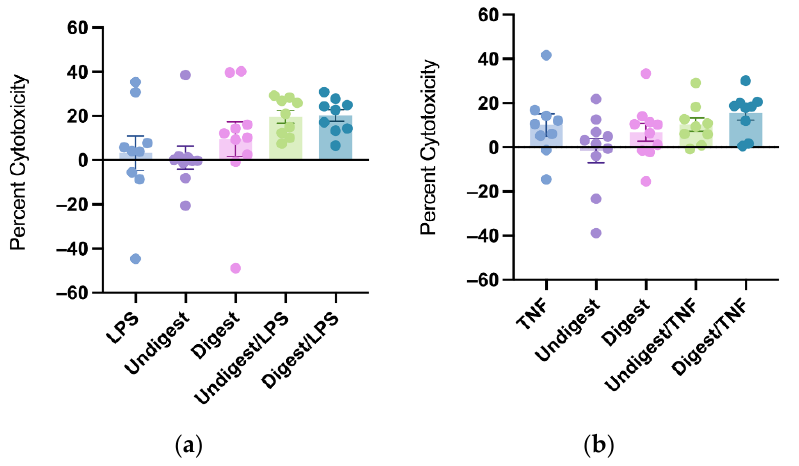
Figure 3. Percent cytotoxicity in response to lipopolysaccharides ( a ) and tumor necrosis factor ( b ) after pretreatment with digested and undigested colostrum. Percent cytotoxicity was examined by the release of lactate dehydrogenase (LDH) calculated as: (Treatment LDH activity − Control LDH activity)/(Maximum LDH activity − Control LDH activity) × 100. Data represented are mean ± standard error (SEM) from nine to ten colostrum samples (outliers removed). Data were analyzed through one-way analysis of variance (ANOVA) followed by Tukey’s multiple comparisons. LPS = lipopolysaccharides; TNF = tumor necrosis